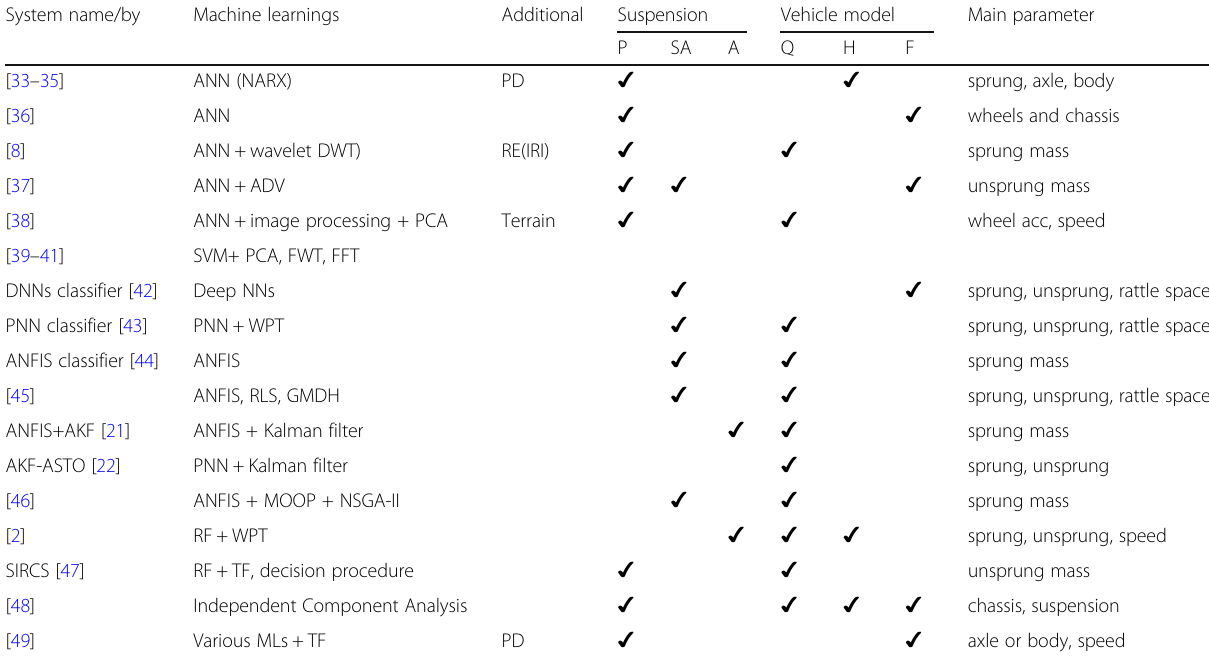
Table 2 Summary of data-driven methods for road profile reconstruction function System name/by